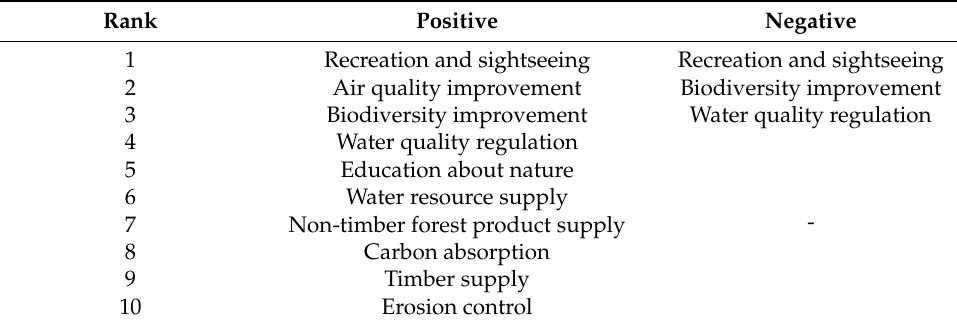
Table 5. Rank by the sentiment analysis in Gariwangsan.